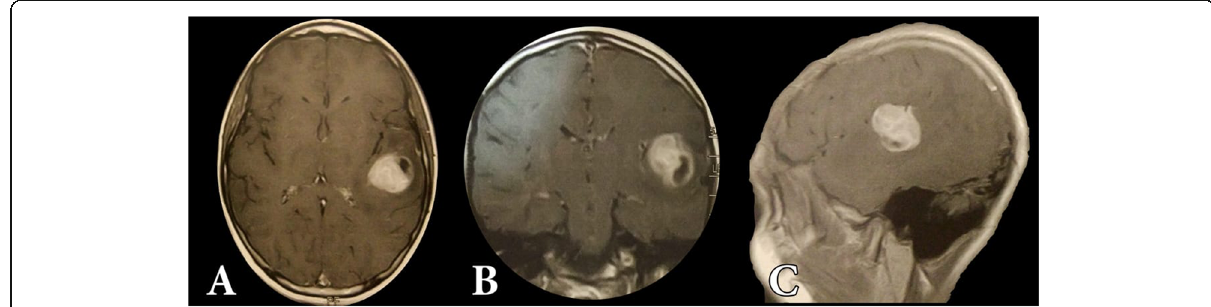
Fig. 3 Preoperative axial ( A ), coronal ( B ), and sagittal ( C ) MRI with gadolinium images of a 14-year-old female patient presented with seizures, showing lt sided sol related to Wernick ’ s area. She was operated under local anesthesia and went home 2 days after